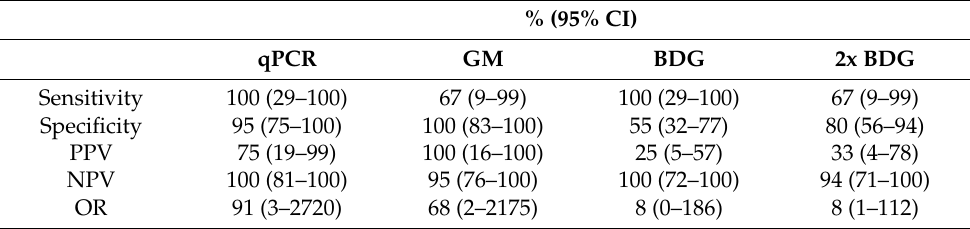
Table 1. Clinical performance in probable invasive aspergillosis (IA) cases. PPV and NPV, positive and negative predictive value, respectively; OR, odds ratio; CI, confidential interval; 2x (1 → 3)-beta- D-Glucan (BDG), 2 consecutive tests were considered as positive.